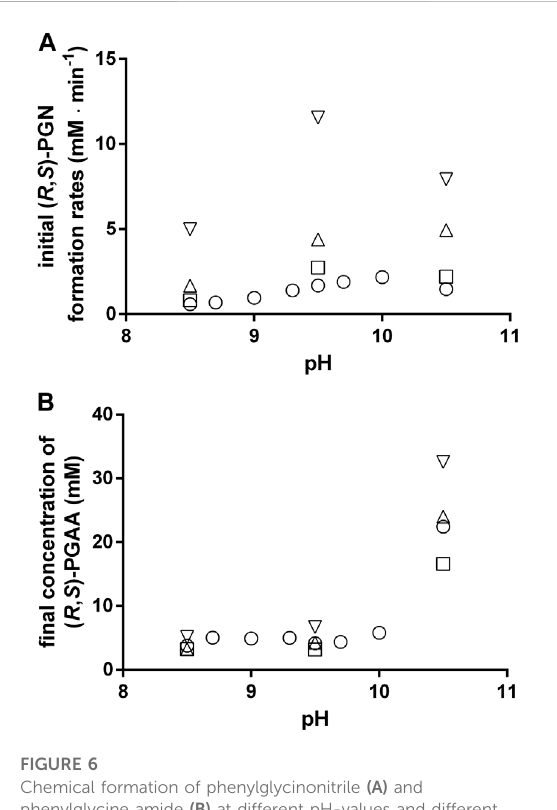
FIGURE 6 Chemical formation of phenylglycinonitrile (A) and phenylglycine amide (B) at different pH-values and different temperatures. The reactions were performed as described in the legend of Figure 2. The reaction mixtures contained at the indicated pH-values 100 mM benzaldehyde, 100 mM KCN, and 1 MNH 4 Clin100 mM Na 2 CO 3 /NaHCO 3 -buffers. The experiments were performed at the following temperatures: 23 ° C ( ○ ), 30 ° C ( □ ), 40 ° C ( △ ) and 50 ° C ( ▽ ). (A) The formation rates of PGN were calculated from the increase in the PGN concentration (measured by HPLC) at the beginning of the experiments. (B) The concentrationsoftheformedPGAAafterthecompleteconversion of the added benzaldehyde were determined by